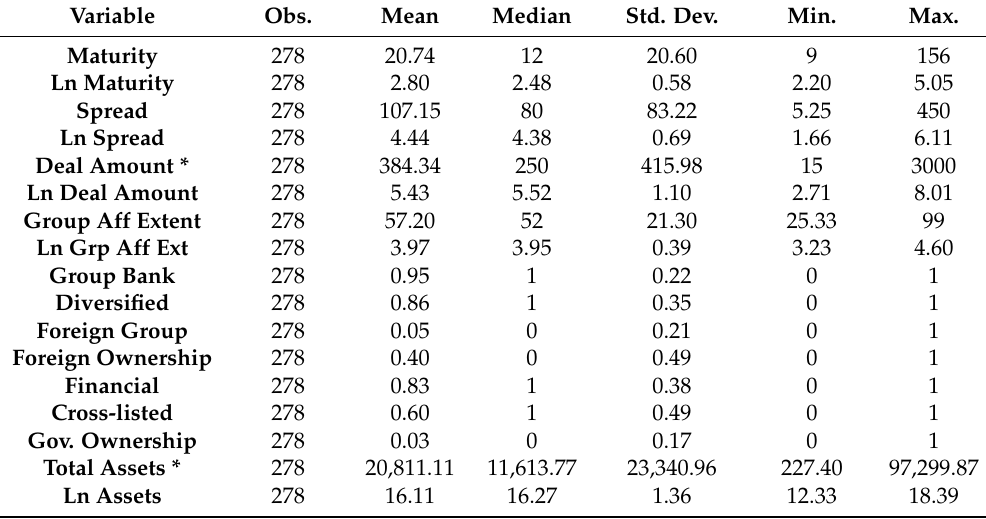
Table 1. Descriptive statistics. Table 1 presents the descriptive statistics for loan contract characteristics (Spread, Deal Amount, Maturity), borrower organizational structure characteristics (Group Affiliation Extent, Foreign Ownership, Foreign Group, Government Ownership, Financial Firm), borrower operational strategy characteristics (Group Bank, Diversification), borrower internationalization characteristics (Cross-listed), other borrower characteristics (Total Assets, Profitability, Tobin’s Q, Leverage, Tangibility), and the time range of the sample data. Deal Amount and Total Assets values are in millions. Maturity is expressed in months. Group Affiliation Extent is calculated based on the ownership percentage information of borrower firms (0% indicates that there is no group association, and 100% means that the associated group owns all the firm’s shares). Binary variables indicate whether a Group Bank, Foreign Ownership, Government Ownership, or Foreign Group Affiliation exist, whether the borrower is Focused or Diversified, whether it is a Financial Firm, and whether it is Cross-listed).